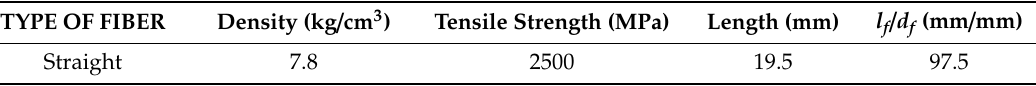
Table 2. Physical properties of steel fiber adopted for the high-performance, fiber-reinforced cementitious composite (HPFRCC).